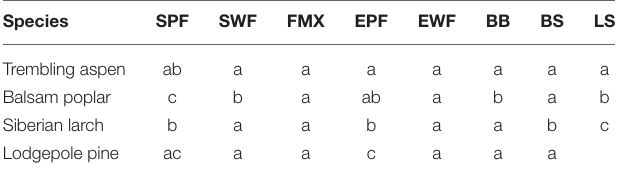
FIGURE 3 | Climate related to critical dates for leaf phenology, phloem and wood formation. (A) Bars represent daily precipitation sums for the period of 1987–2017 (light blue) and the year 2018 (dark blue). (B) Lines represent 5 days running means of the previous 5 days of maximum, average, and minimum temperature for the period of 1987–2017 (light blue) and the year 2018 (dark blue). (C) Dots indicate the date of activity. The dates are based on Gompertz-fits to biweekly measurements of xylem and phloem development. The dates for leaf phenology are based on biweekly assessments of leaf formation and senescence. Dots are colored by species. Of all four species, balsam poplar had the shortest growing season as defined by the period between the start and end of wood formation and the duration of leaf presence while larch had the longest duration of wood formation and leaf presence. The start of wood formation and the date of bud break were similar in all species. By contrast, the end of phloem formation, wood formation, and the date of bud set were highly variable across species. TABLE 1 | Multiple comparisons among species in dates (Day of Year) of phloem and wood formation as well as leaf phenology.